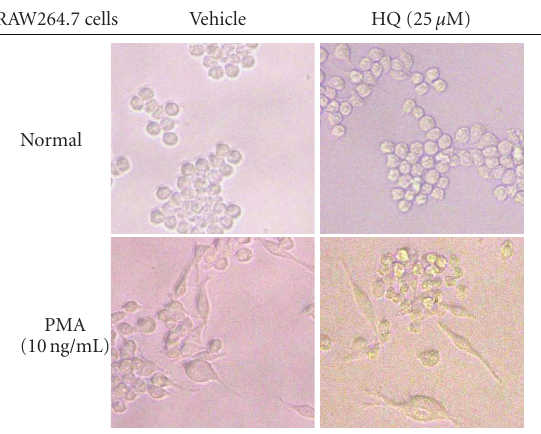
Figure 7: E ff ect of hydroquinone on PMA-induced morphological changes. RAW264.7 cells (1 × 10 5 ) were incubated with indicated concentrations of HQ (hydroquinone) in the presence or absence of PMA (10 ng/mL) for 72 hours. The images of the cells in culture were obtained using an inverted phase contrast microscope attached to a video